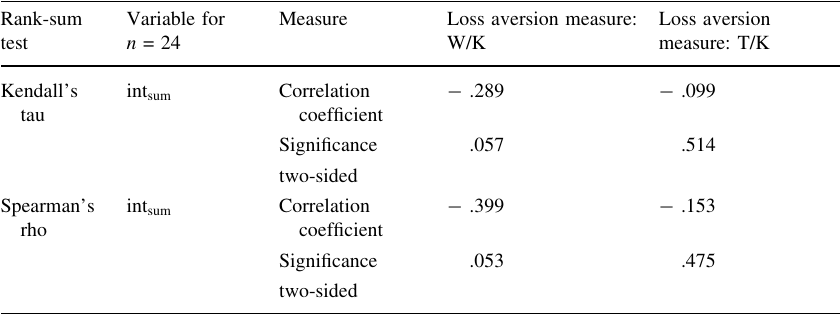
Table 6 Intention and loss aversion measures correlation using rank-sum tests’ Kendall’s tau and Spearman’s rho Rank-sum